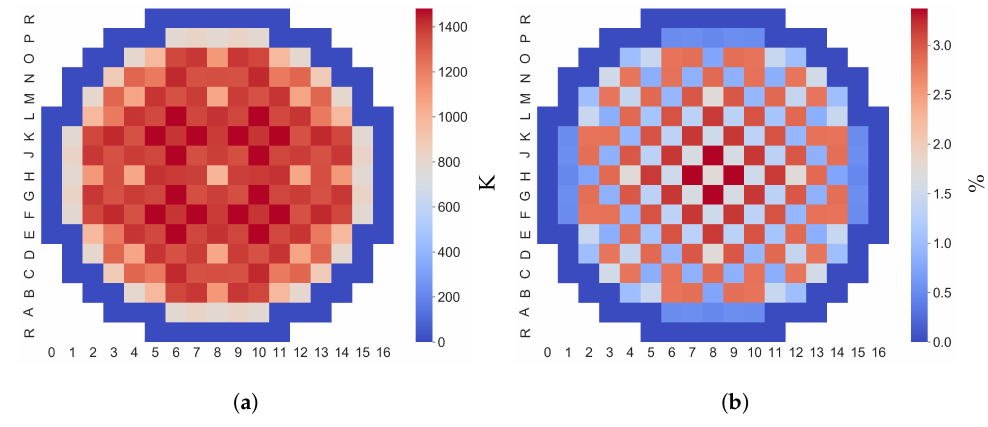
Figure 20. Radial profile of T ave